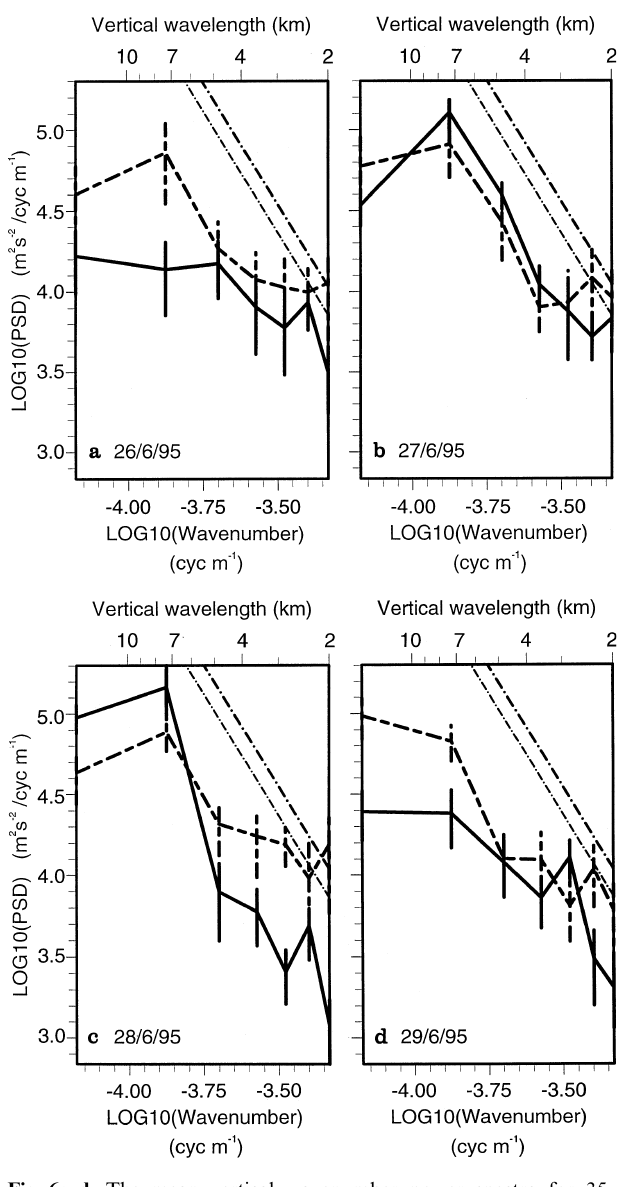
Fig. 6a–d. The mean vertical wavenumber power spectra for 35– 50 km and 50–65 km, represented by full and broken lines , respec- tively, derived from observations on the nights of a 26, b 27, c 28 and d 29 June 1995, the vertical bars representing one standard deviation either side of the mean values. The dot-dash lines represent the saturation power spectral densities, N 2 , the heavy and light lines 10 m 3 referring to the 35–50-km and 50–65-km, height ranges,